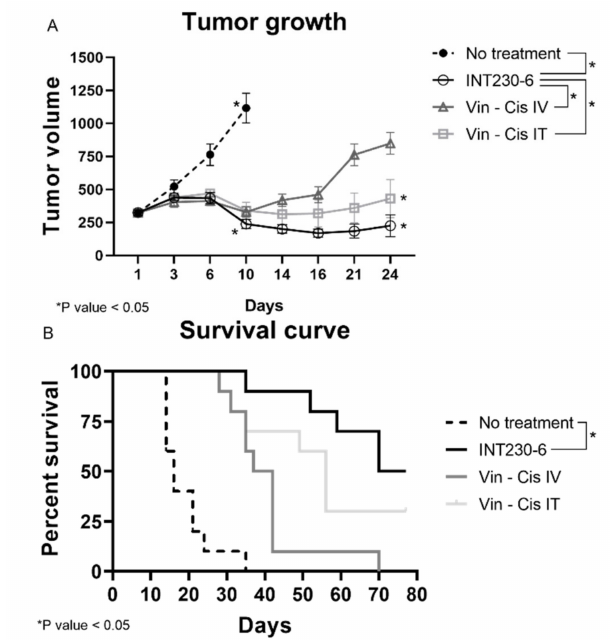
Figure 3. INT230-6 in vivo treatment of Colon-26 tumors Tumor Growth Inhibition. BALB / c female mice were inoculated with 1 × 10 6 Colon-26 tumor cells in the right flank (cell injection volume, 0.1 mL / mouse). A total of 10 mice were assessed in each group and treated with intratumoral (IT) doses of INT230-6 or IT Vinblastine + Cisplatin or IV doses of Vinblastine + Cisplatin when mean tumor volume reached 325 mm 3 (dose was 100 µ L / 400 mm 3 tumor volume). Cisplatin was administered at 0.5 mg / mL while Vinblastine at 0.1 mg / mL once a day for 5 consecutive days (QDx5). ( A ) Tumor growth curves represented by the mean tumor volume of each group and error bars represent the SEM. Asterisks are representative of p values < 0.05 in the group’s comparison calculated with two-way ANOVA. ( B ) Kaplan–Meier survival curves of the Colon-26 tumor bearing mice. Asterisks are representative of p values < 0.05 in the group’s comparison and calculated through Log-Rank (Mantel-Cox)